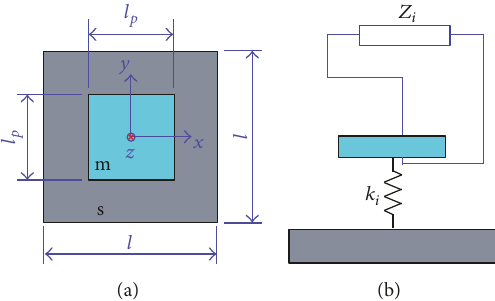
Figure 3: Unit cell of periodic subwavelength structure: (a) top view and (b) equivalent flexible connection and piezoelectric shunt